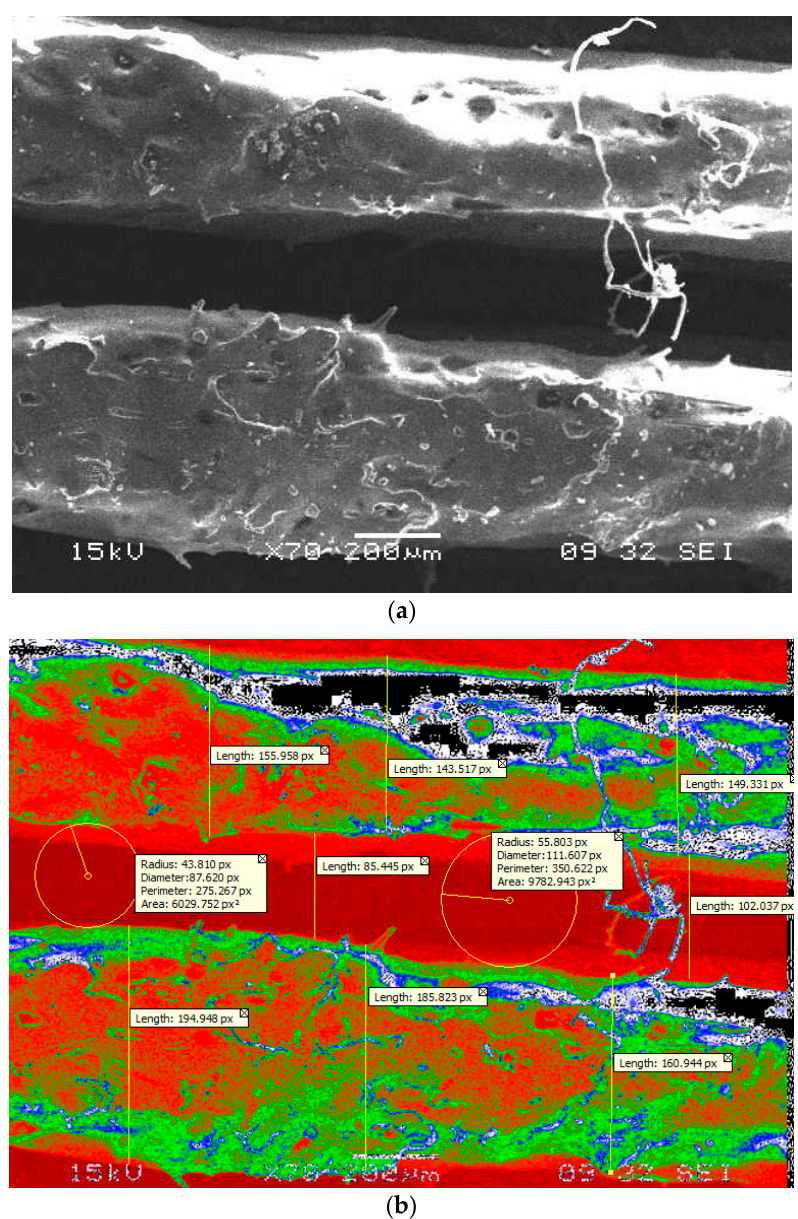
Figure 16. ( a ) SEM micrograph at 200 µm, ( b ) assessment of fibers at 45° by image segments analysis.